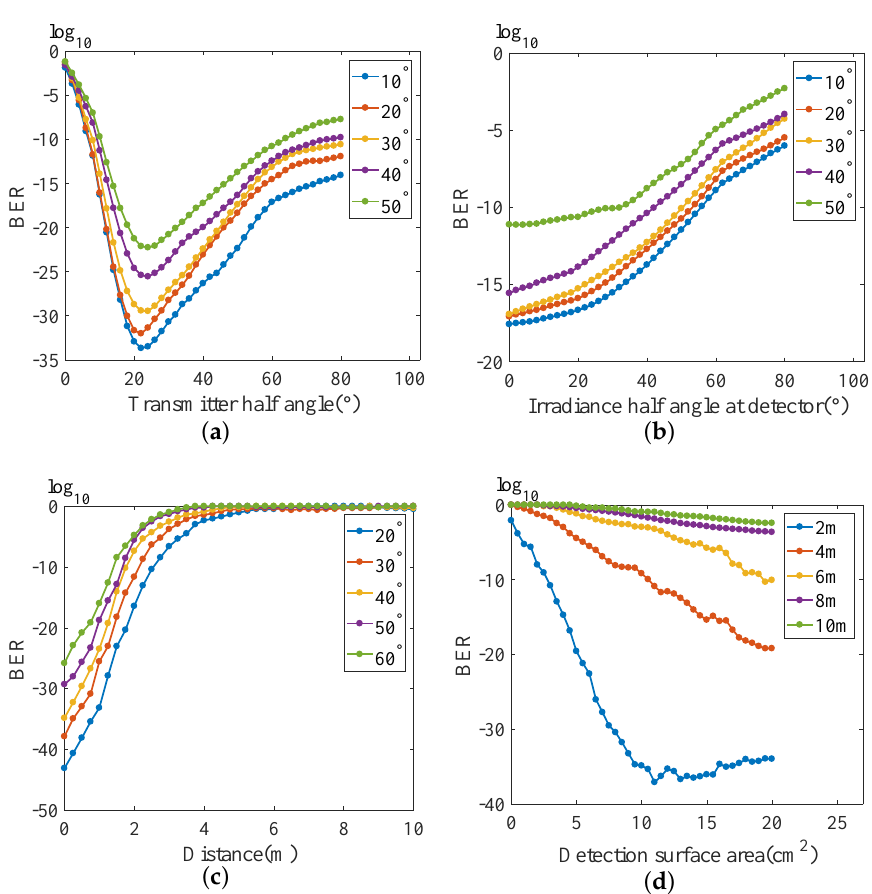
Figure 3. Theoretical simulation results. The relationships between: ( a ) the irradiance half angle at the source and the transmitter half angle; ( b ) the irradiance half angle at the source and the irradiance half angle at the detector; ( c ) the transmitter half angle and communication distance; and ( d ) communication distance and detection surface